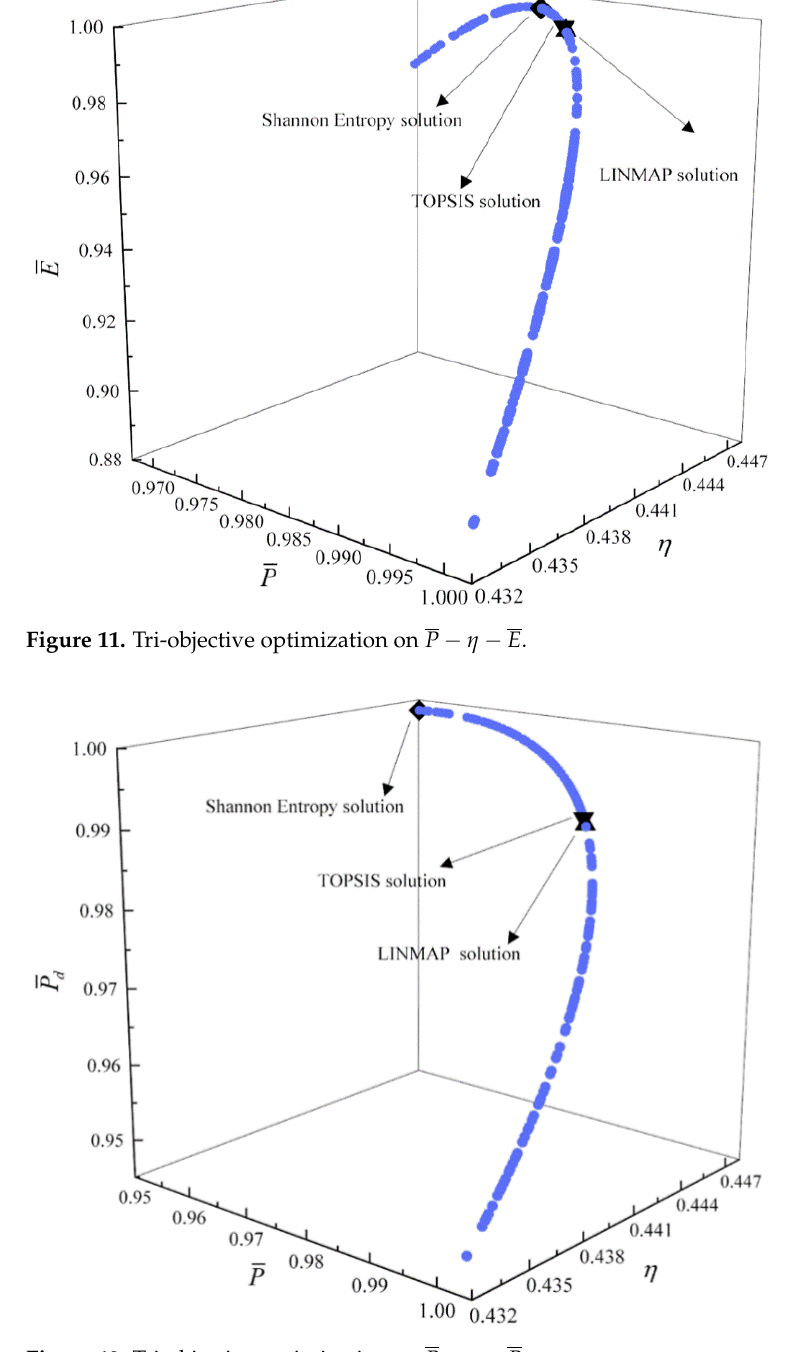
Figure 12. Tri-objective optimization on P − η − P d